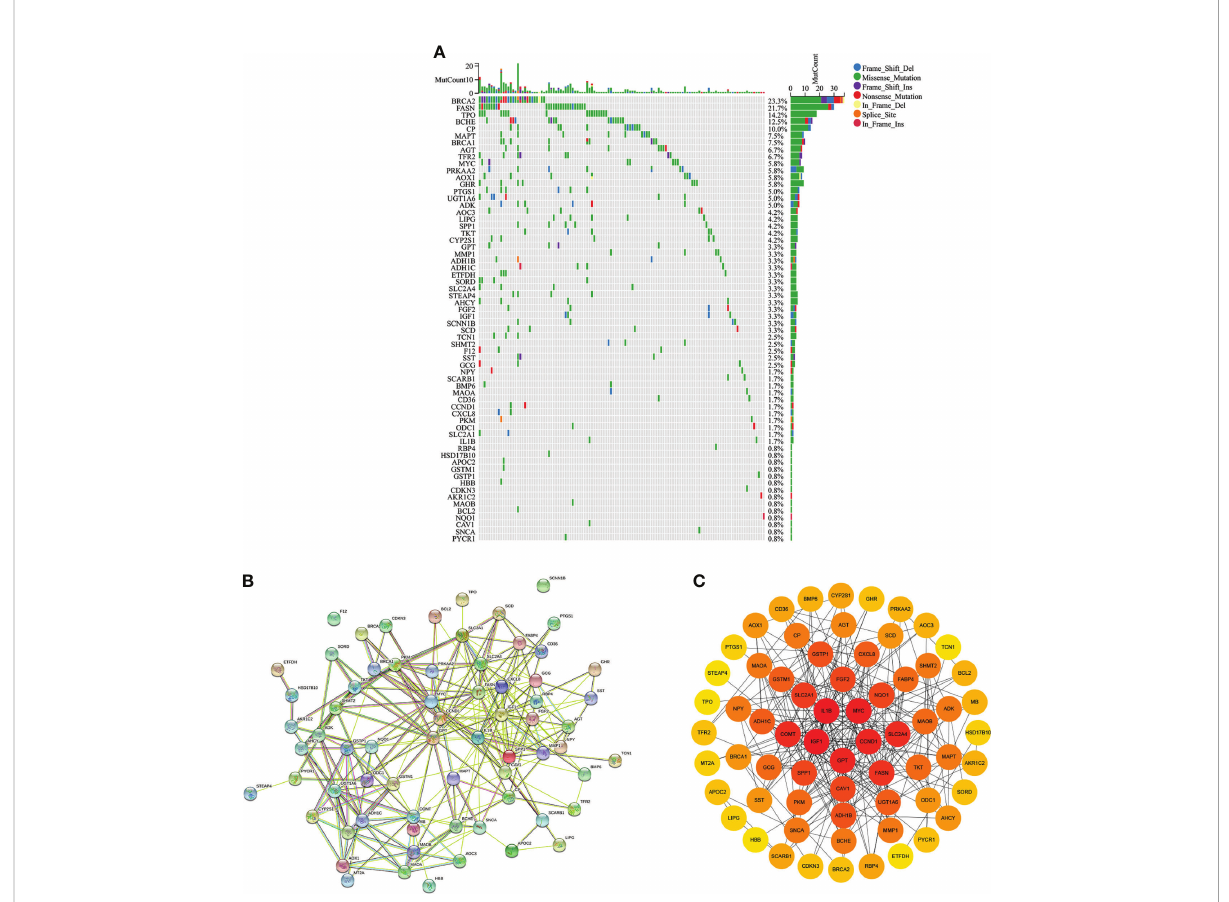
FIGURE 3 Gene mutation and protein interaction. (A) Mutations of differentially expressed CMRGs in COAD tumors. (B) Protein interactions of differentially expressed genes in STRING database. (C) Cytoscape software analyzed the degree of interaction between differentially expressed